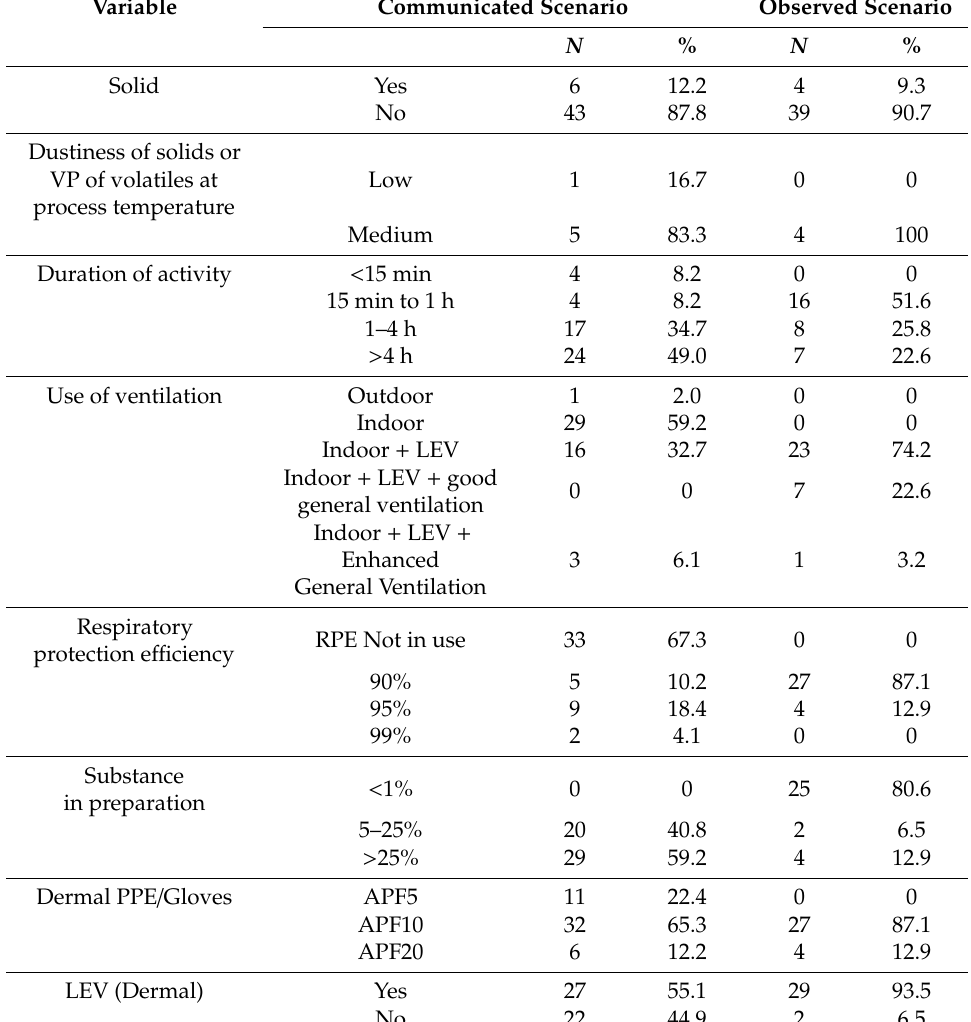
Table 4. Number (N) and percentage (%) of PROC’s characterizing parameters collected for ECETOC TRA v.3.1 in the communicated scenario and observed